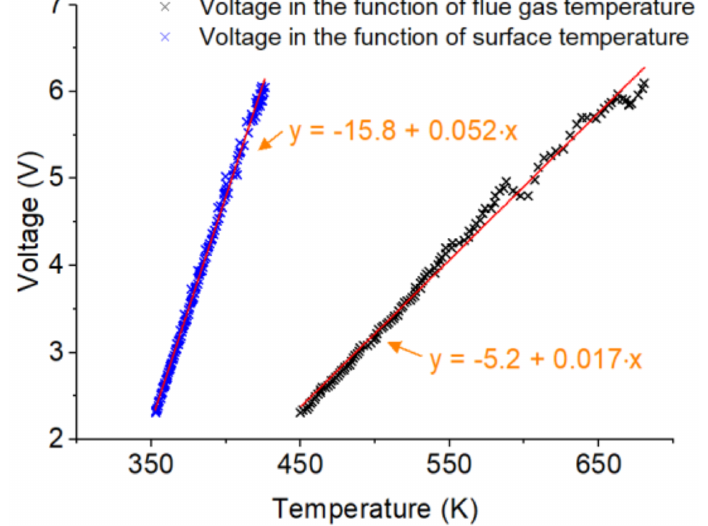
Figure 15. Variations as an output voltage in the function of flue gas temperature and hot surface temperature (on the example of TEG No. 4).